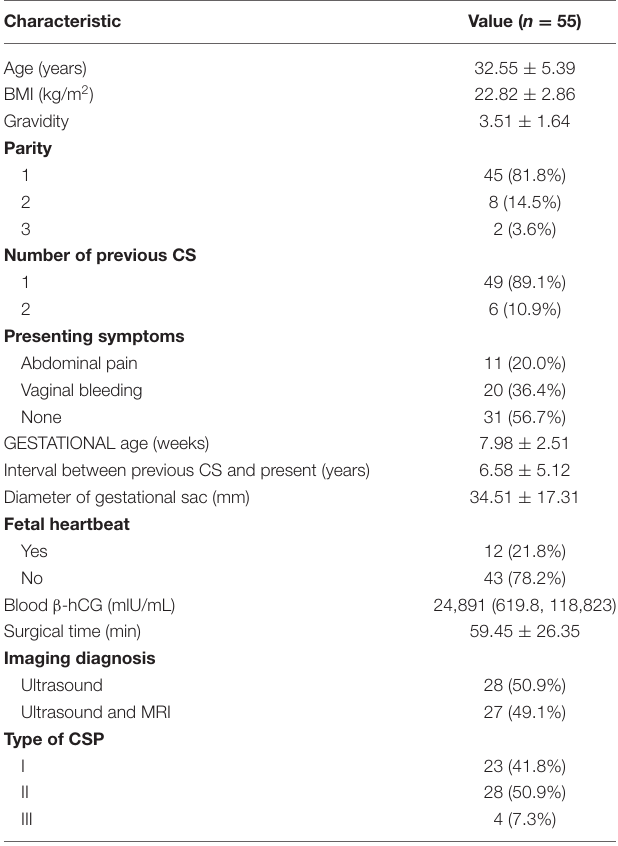
TABLE 1 | Clinical characteristics of the 55 CSP patients involved in the current